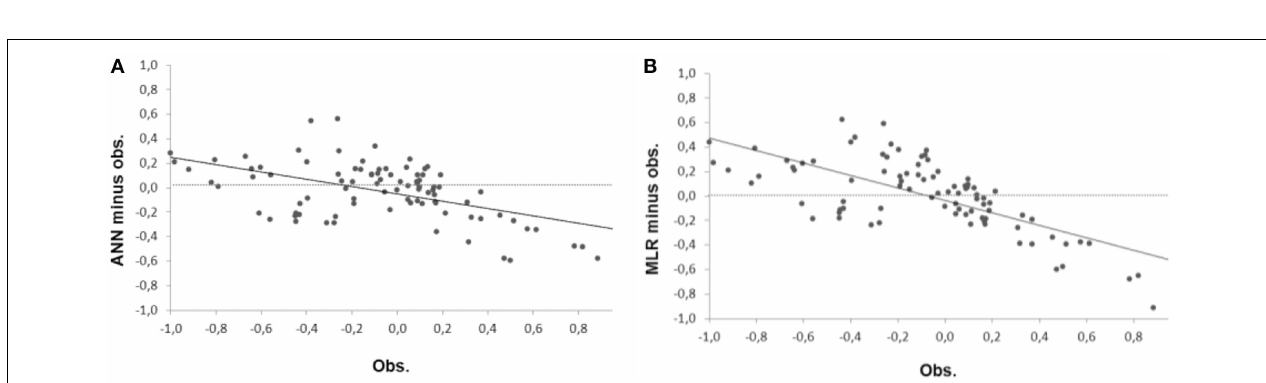
FIGURE 9 | Comparison between the observed (gray line) and simulated daily precipitation by the ANN (blue line) and MLR (red line) models during FMA season of the 1963–2003 period over the north of the NEB.